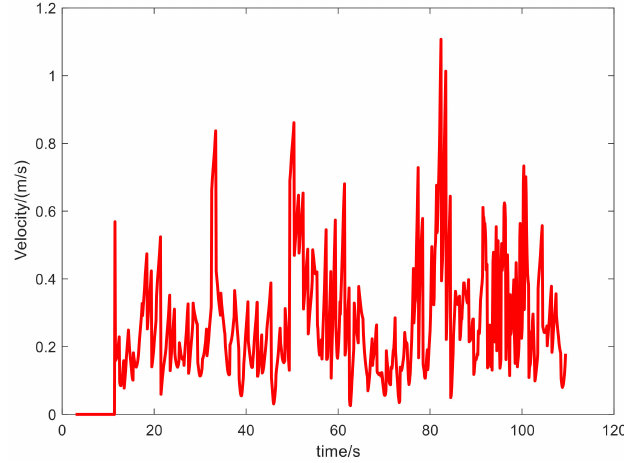
Figure 18. Variation curve of velocity with time.